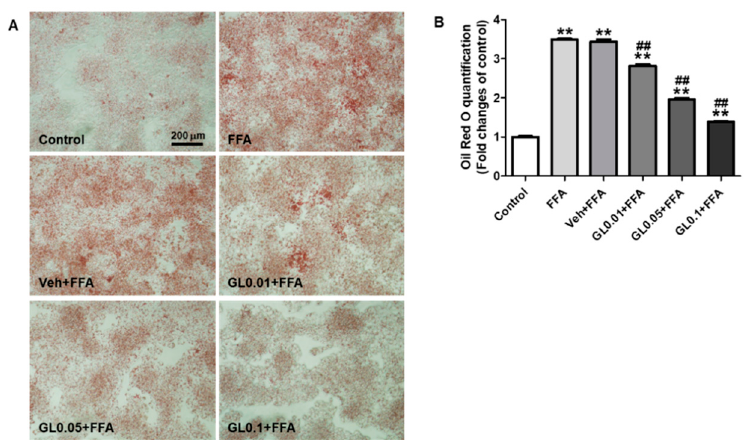
Figure 7. GL attenuated FFA-induced lipid accumulation in HepG2 cells. ( A ) Representative pictures (magnification 200×, scale bar = 200 μ m) of Oil Red O stain in HepG2 cells from three independent experiments and ( B ) the quantification of lipid contents. HepG2 cells were treated with FFA (1 mM) for 24 h, and the cells were stained with Oil Red O dye. GL extract was pretreated 1 h prior to FFA treatment in the indicated concentrations, and control cells were treated with fatty acid-free BSA (1%). Data are the means ± SEM. ** p < 0.01 vs. control group; ## p < 0.01 vs. FFA group.